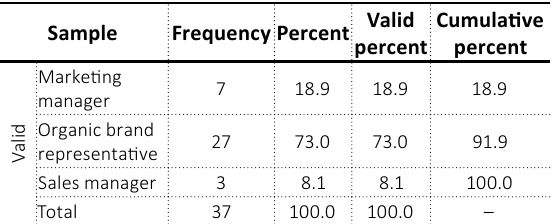
Table 3. Sample characteristics according